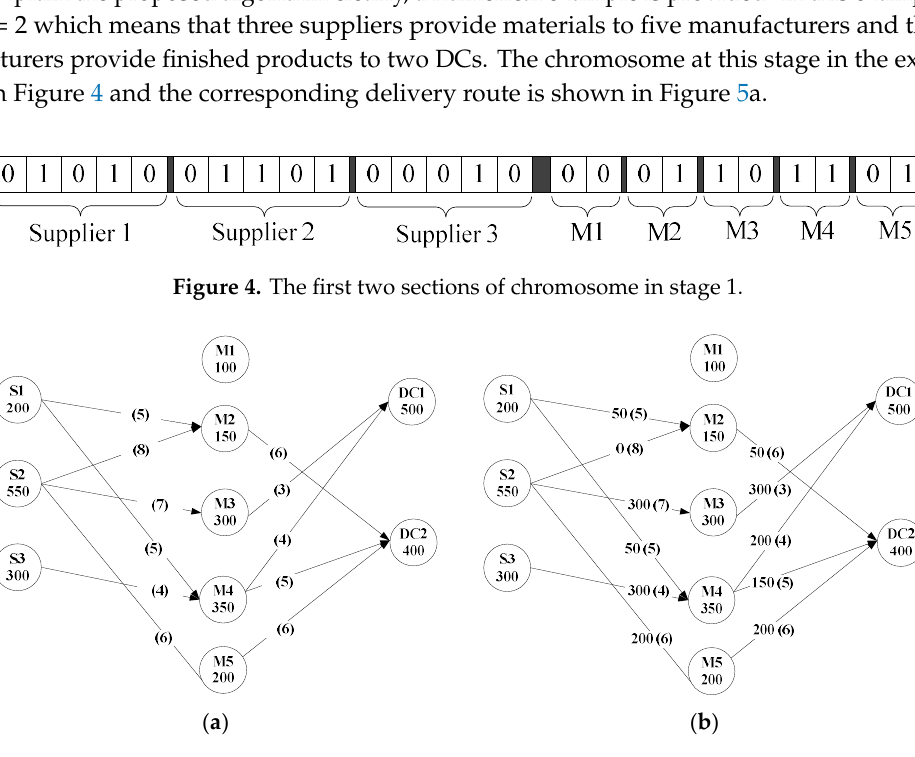
Figure 5. ( a ) Delivery route of the numerical example. ( b ) Network of the numerical example.